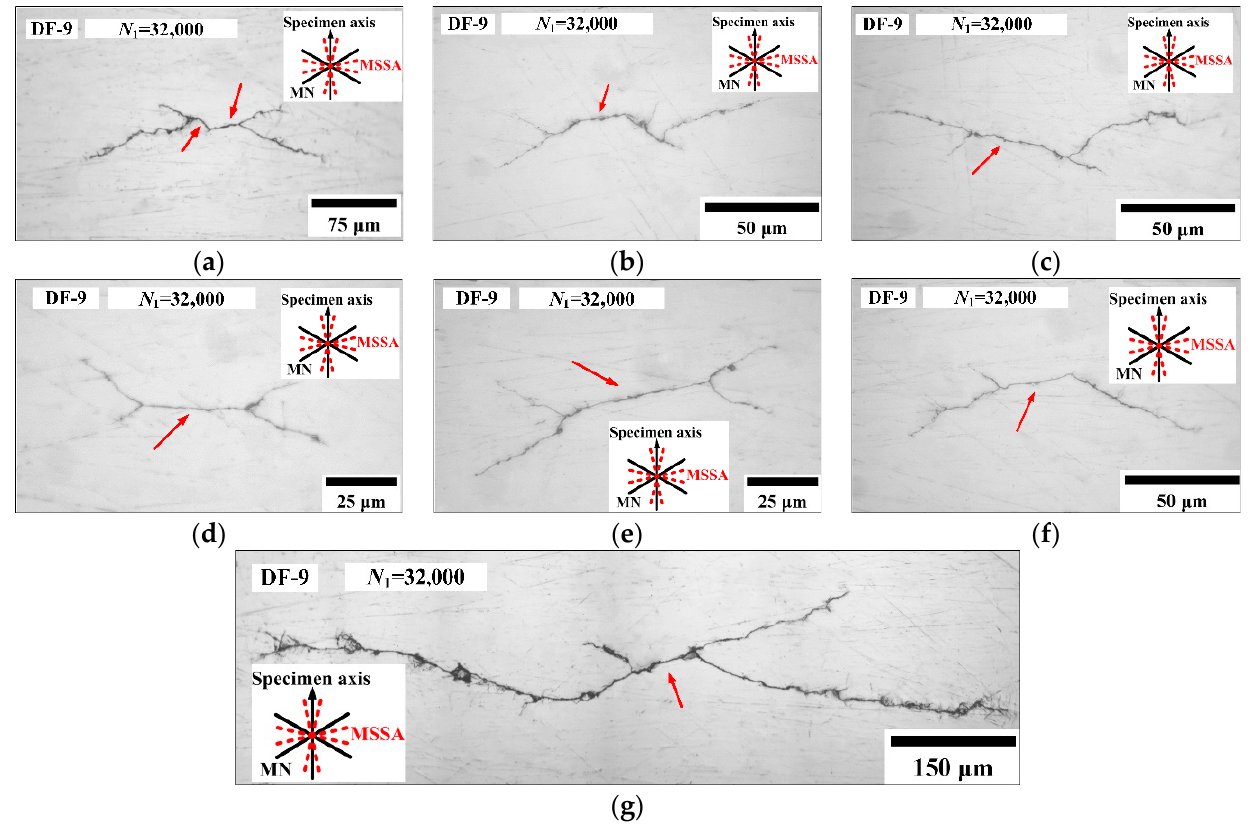
Figure 9. Secondary cracks ( a – f ) and main crack ( g ) in specimen DF-9.